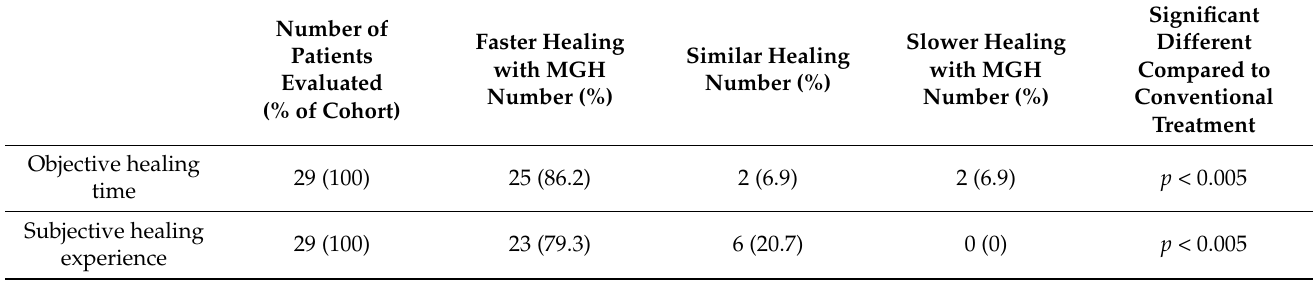
Table 1. Efficacy MGH treatment on the objective and subjective healing time when compared to conventional